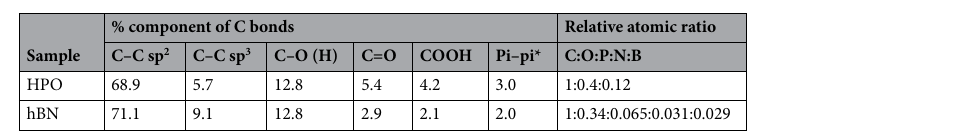
Table 1. Percentage of C1s component concentration derived from the C1 s peak deconvolution (Fig. 2) and relative atomic ratio C:O:P of the GA and C:O:P:N:B of the HA sample.